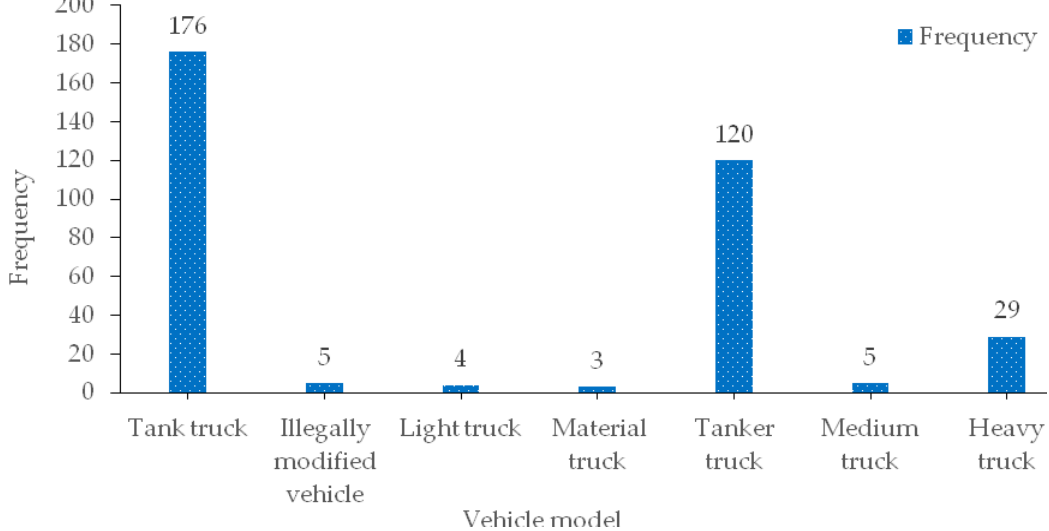
Figure 6. Vehicle models distribution characteristics of road hazardous materials transportation accidents.